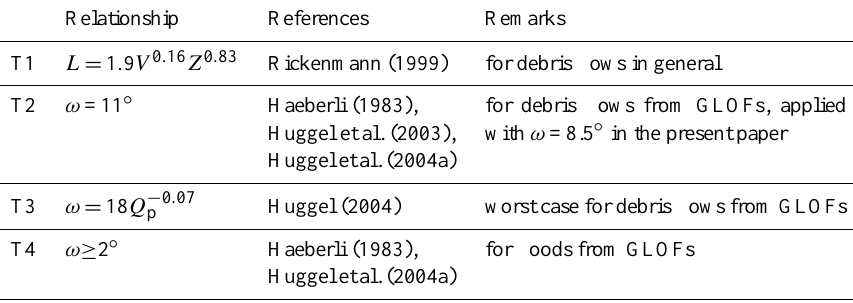
Table 5. Empirical relationships potentially suitable for estimating the travel distance of lake outburst floods.